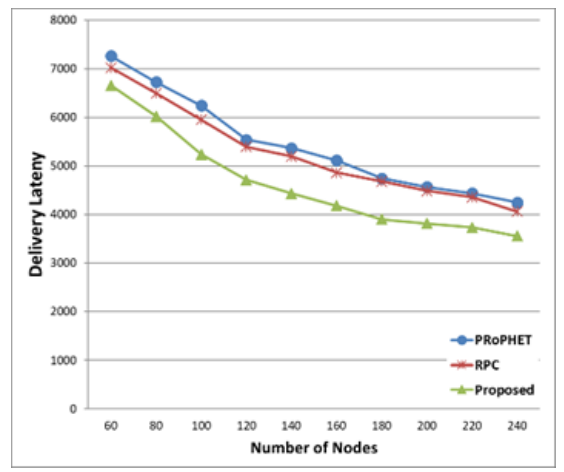
Figure 13. Delivery latency for different number of nodes.